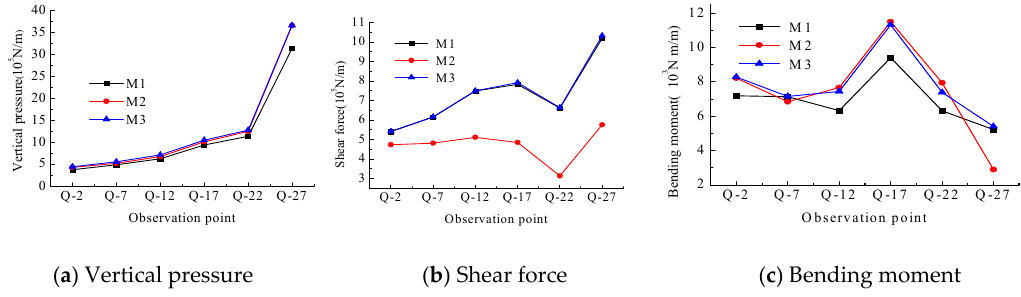
Figure 18. The peak internal forces of surface-6 under El-Centro motion.